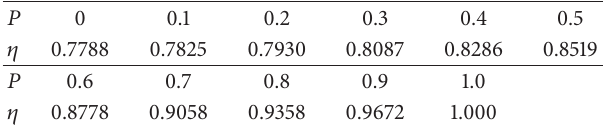
Figure 5: 𝜋 -type circuit of a hollow cylinder section. Table 1: Values of geometrical factor 𝜂